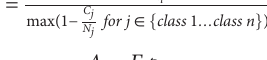
Eq. 1: Calculation of the proportion of miss-classi fi ed images to be added to the updated training dataset (top) and calculation of the number of images to be added to the training set (bottom). i =